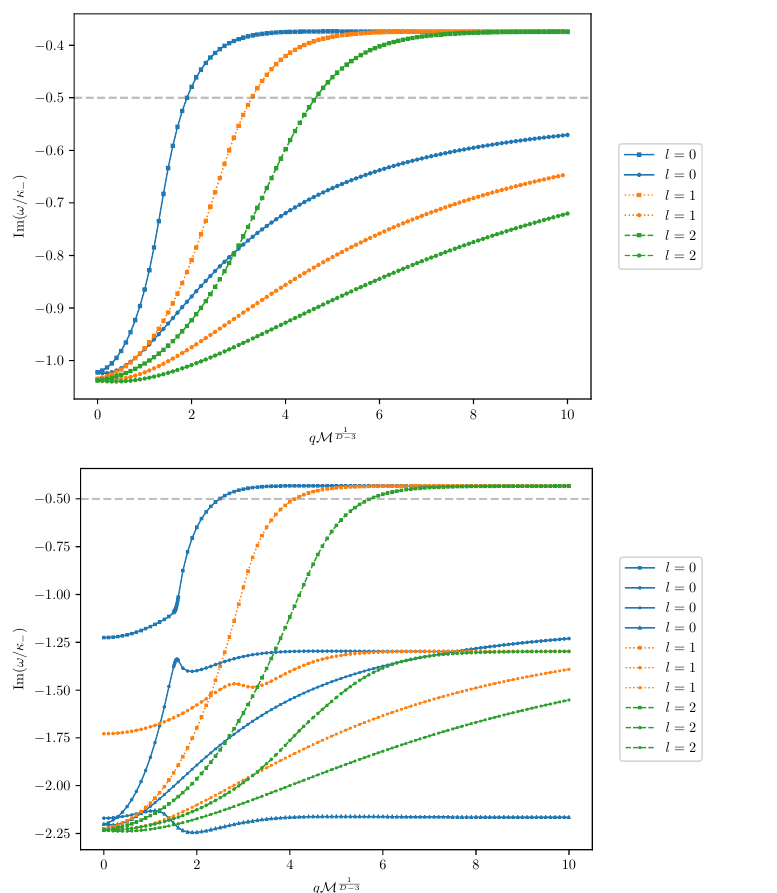
Figure 2 . The imaginary part of the low-lying quasinormal modes for (cid:3) the top is for and Q = 0 : 996 and the bottom is for Q Q max